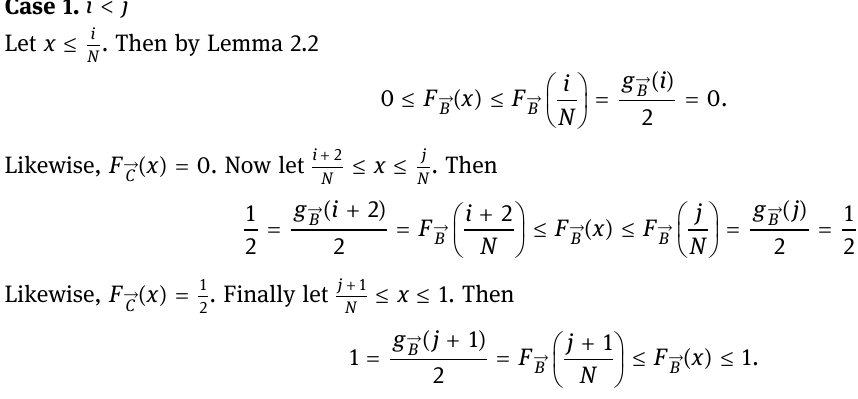
( blue ) and F ( red ) C → B →